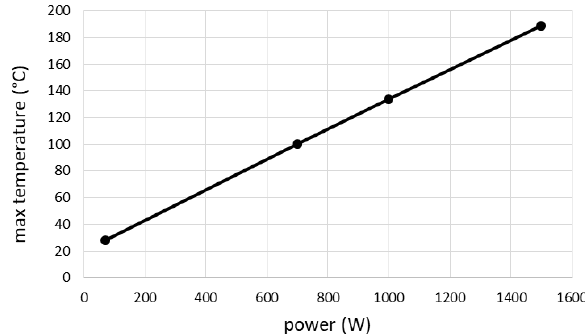
Fig. 11. Summary of the maximum temperature of the Be component versus beam power of the ANSYS model of CoolGAL using water coolant flowing at v = 2 m/s with an input temperature of